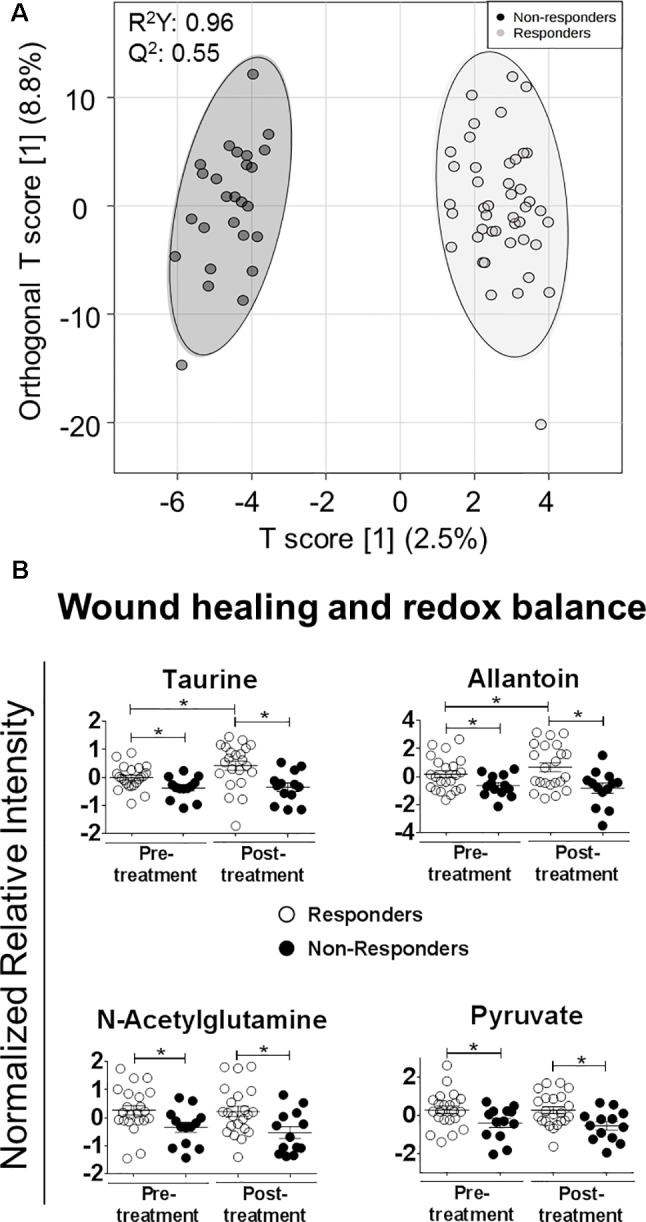
Metabolites associated with wound healing and redox balance are more abundant in CL patients who cured. (A) OPLS-DA model of metabolites depicts the separation of all samples (pre- and post-treatment) in each group (responders and non-responders), each circle representing an individual sample. (B) Scatter dot plots of selected metabolites differentially abundant between responders and non-responders. Whiskers represent the 5–95 percentile. Data were normalized using the pooled sample from plasmas of the responders group. Statistical significance was determined using t-test. *p <0.05.